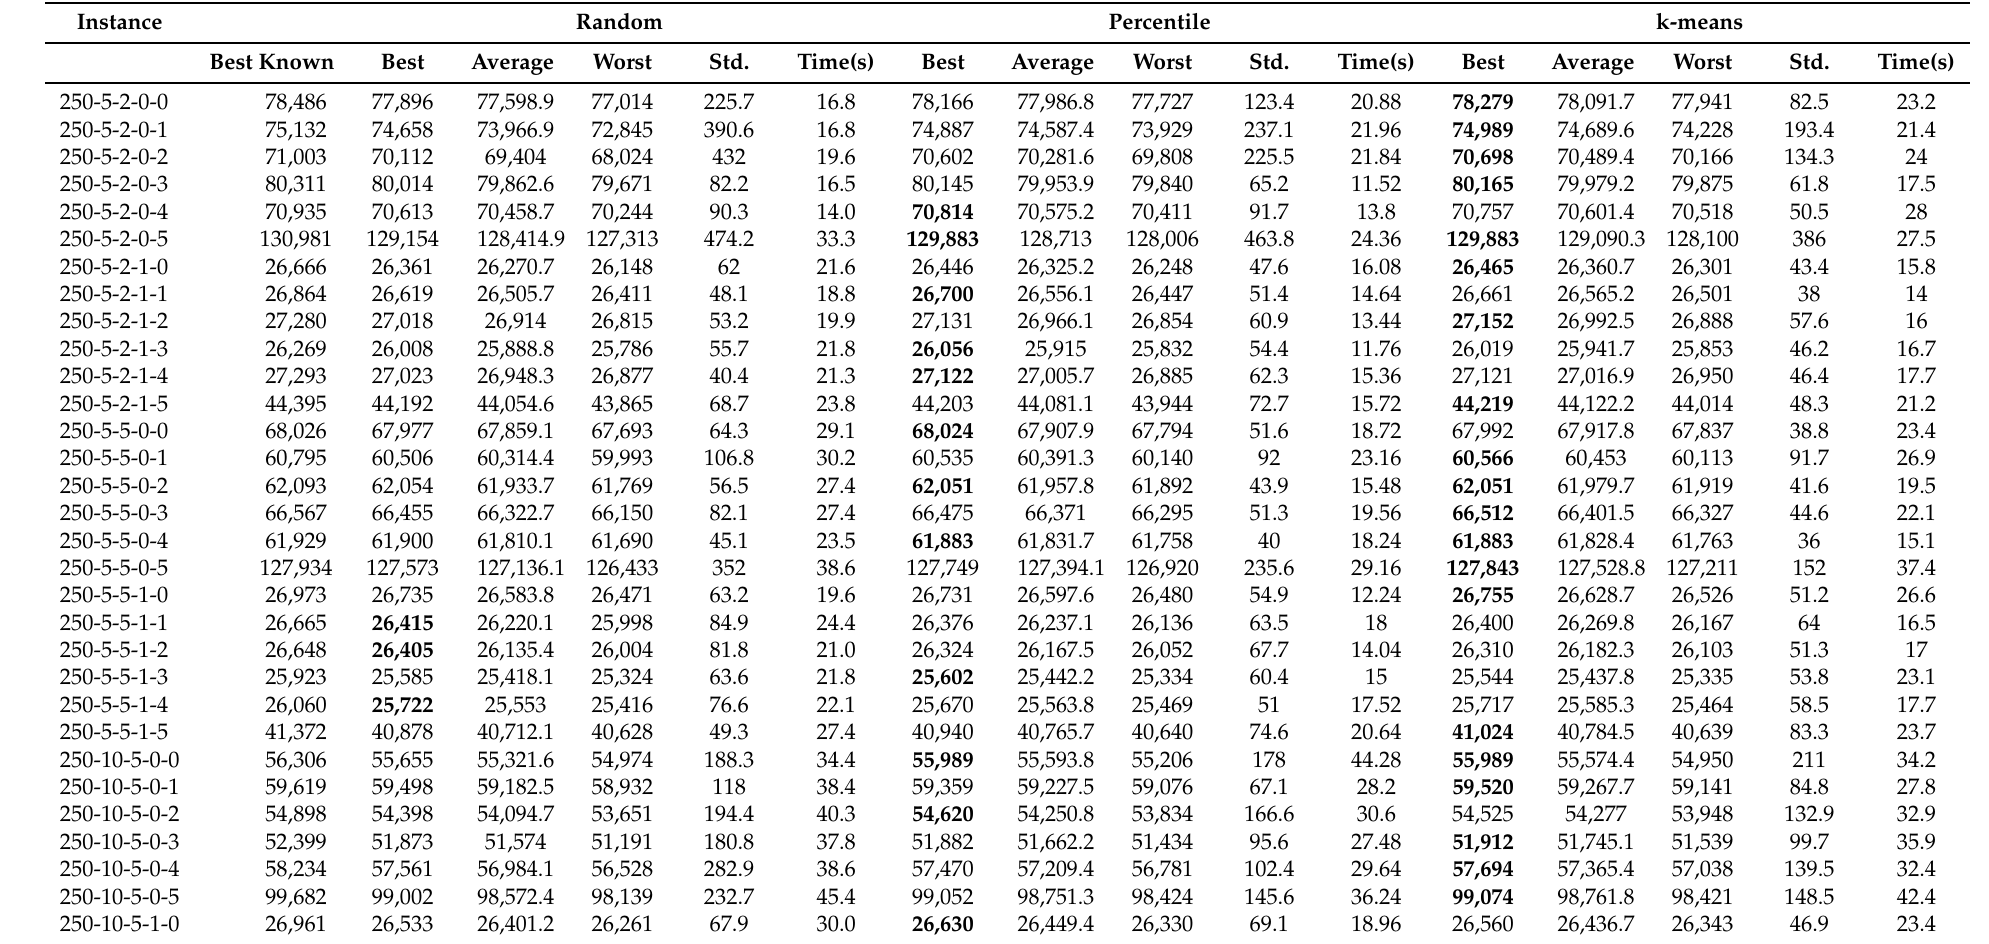
Table 3. Comparison between Random, Percentile and K-means binarization methods for 250 instances and cuckoo search algorithm. The Bold represent the best result obtained when comparing the three